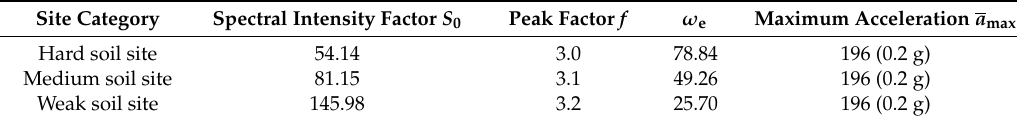
Table 1. Intensity factor of the C-P model spectrum.